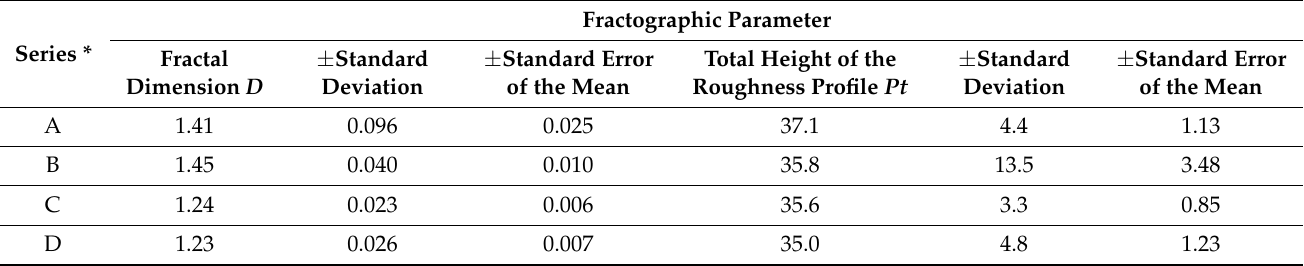
Table 3. Summary of the results of the fractographic examination of profile lines.